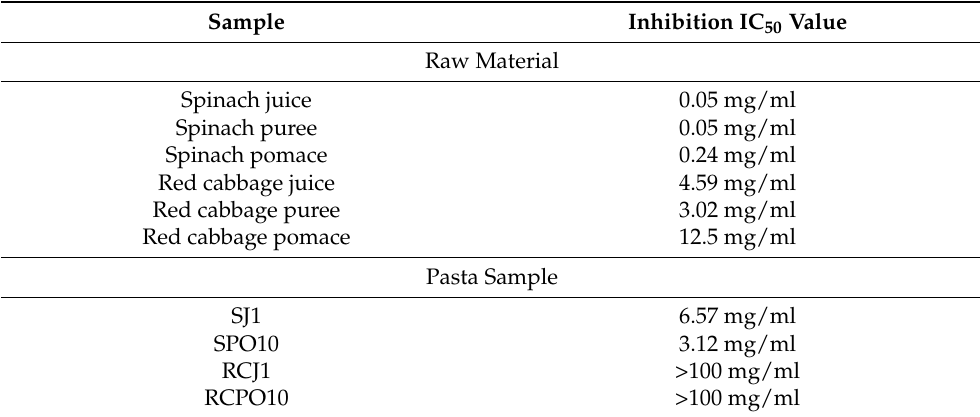
Table 3. α -amylase Inhibition of Raw Materials and Spinach Pasta Sample.